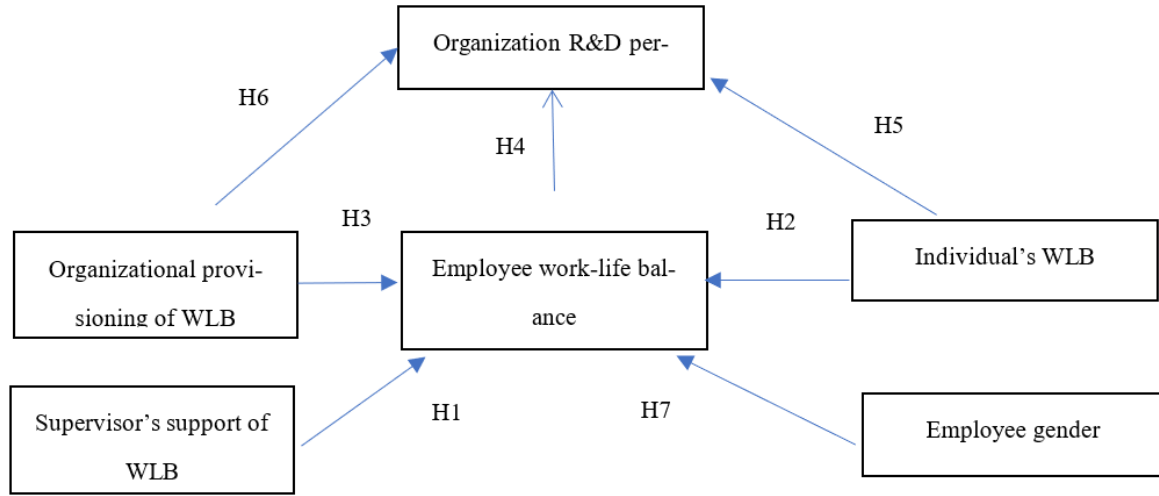
Figure 1. The conceptual model of the research.